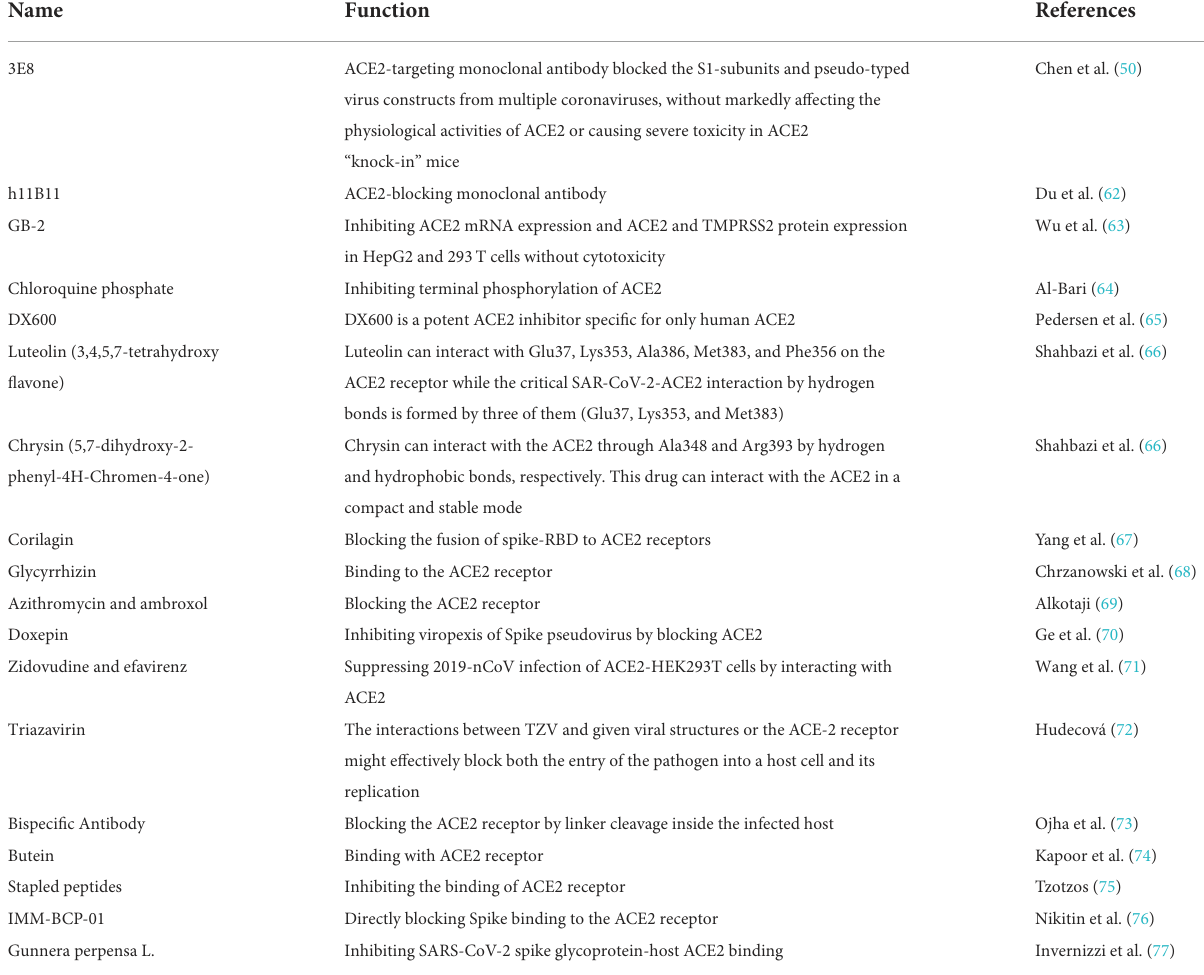
TABLE 1 Development of angiotensin converting enzyme 2 (ACE2) targeted strategies for the treatment and prevention of coronavirus disease